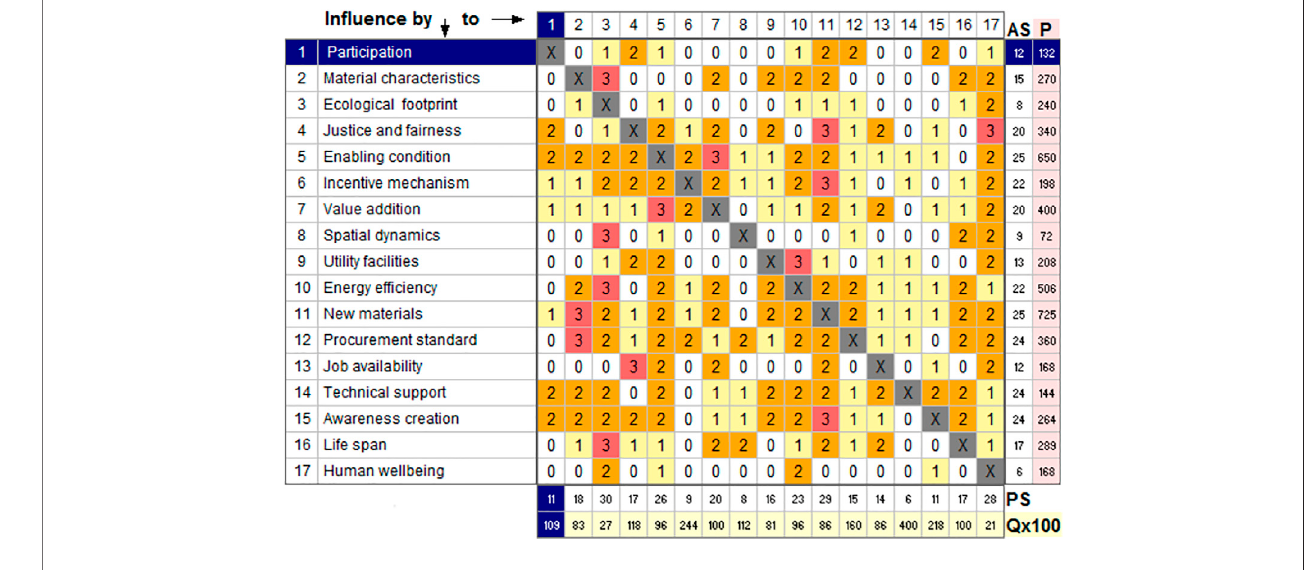
FIGURE 3 | Cross impact analysis.